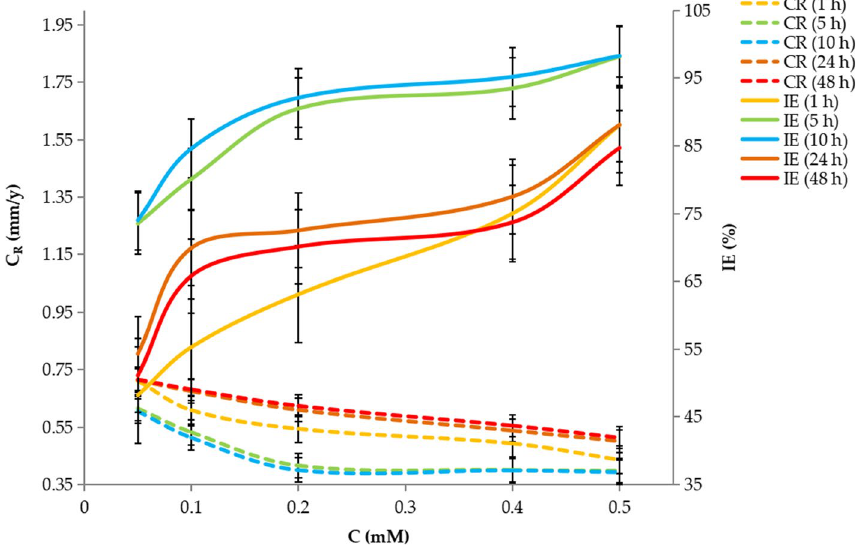
Figure 3. Corrosion rate and inhibition efficiency for MS in 1 M HCl at different immersion times and nonanedihydrazide